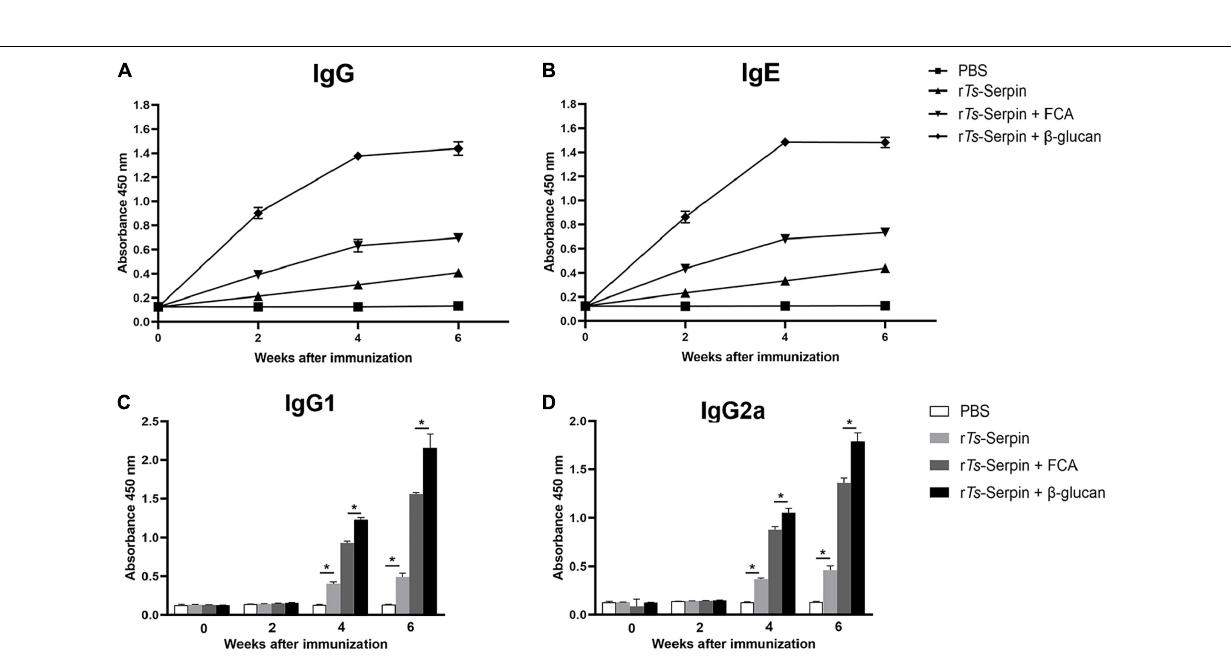
Frontiers in Cell and Developmental Biology | www.frontiersin.org